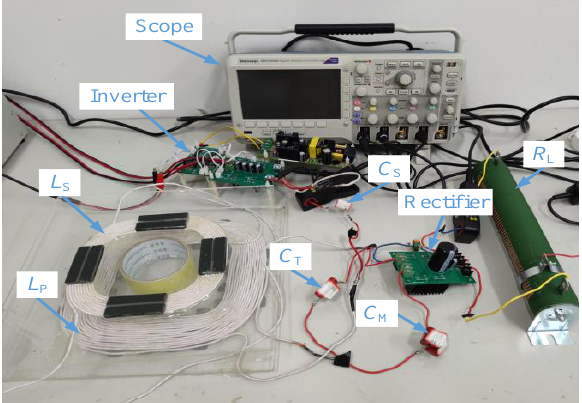
Figure 9. Experimental model of the S/PS−compensated WPT system. Table 3. Measured parameter values of the S/PS − compensated WPT